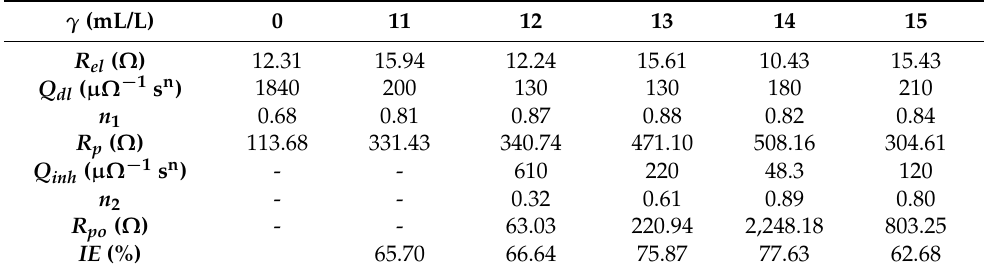
Figure 8. Bode plots scanned on the carbon-steel sample in the simulated brine saturated with CO 2 with and without the inhibitor in flow conditions (Adapted from [24]). Table 6. Electrochemical parameters determined from Nyquist and Bode plots scanned on the carbon-steel sample in the simulated brine saturated with CO 2 with and without the inhibitor in flow conditions (Adapted from [24]).